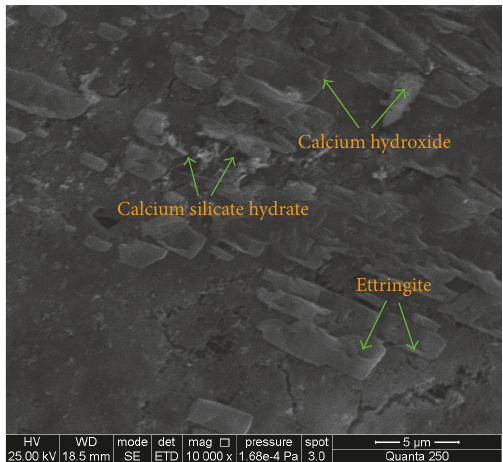
Figure 5: SEM image obtained from the bubble wall.